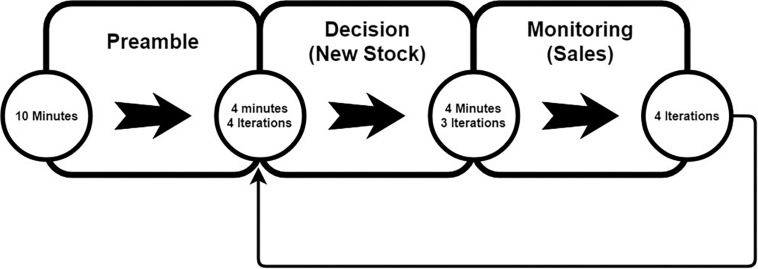
Simulated business task timeline.